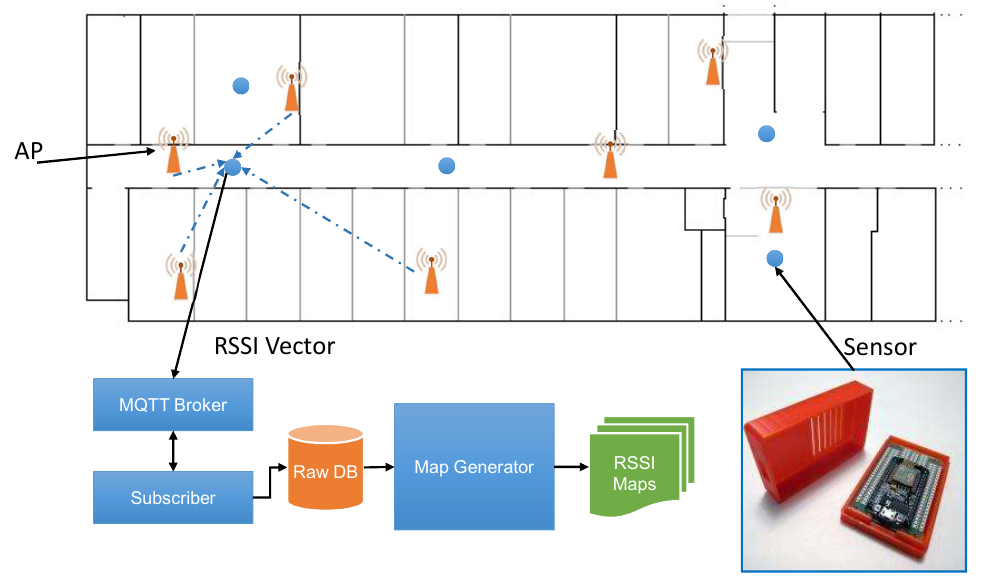
Figure 1. The system configuration diagram includes the sensors, APs; access points, and information flow from a sensor to the radio map generation